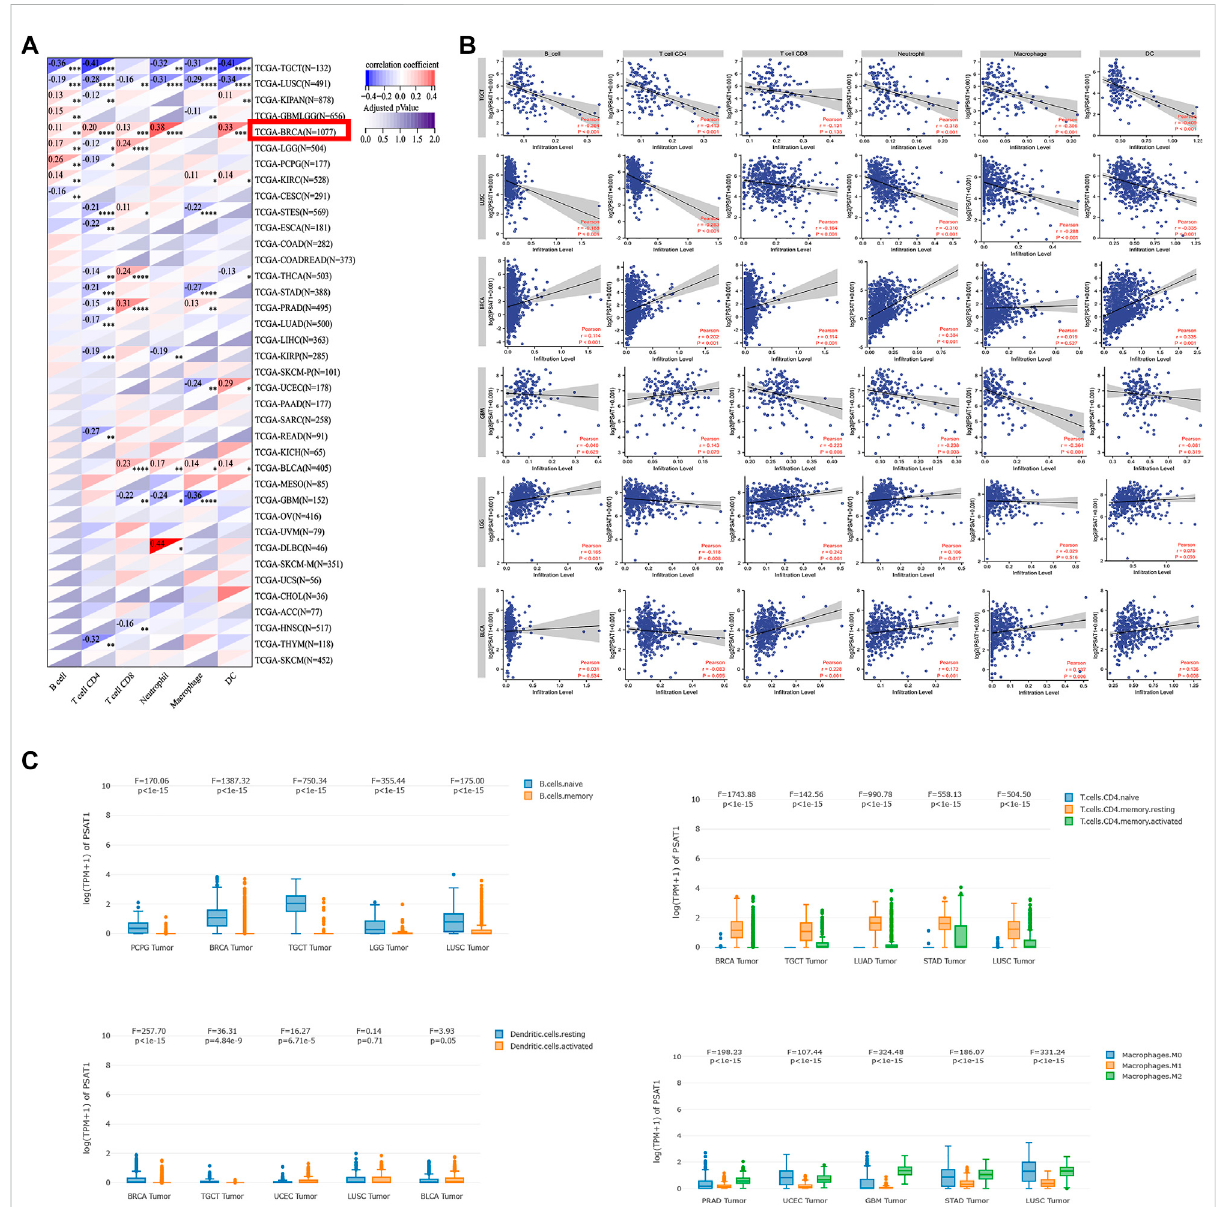
FIGURE 7 Correlation analysis between PSAT1 expression and immune in fi ltration of cancer-associated fi broblasts. (A) Heatmap showing correlation of PSAT1 expression with in fi ltration by six immune cell types, * p < 0.05; ** p < 0.01; *** p < 0.001; *** p < 0.0001 (B) The detail relationship betweenthe expression of PSAT1 and six immune cells in fi ltration in TGCT, LUSC,BRCA,GBM, LGG and BLCA. (C) The expression changes of immune cell subsets in different